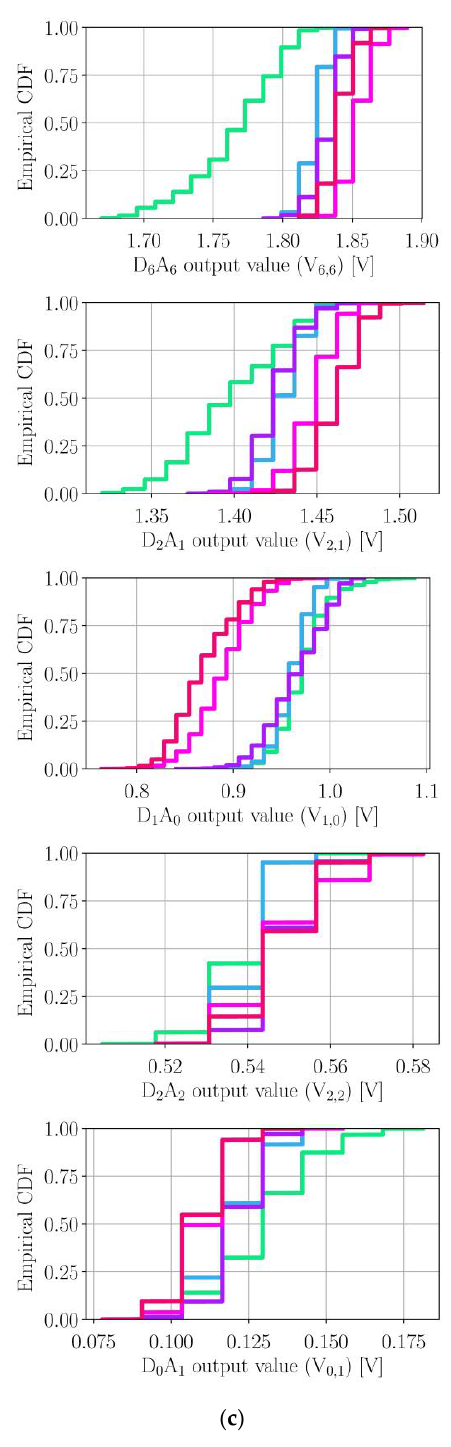
Figure 4. Results of the stability experiment, only including folded states. ( a ) Visualization of the textile output in an example folded state; ( b ) textile sensor values in a folded state over the course of 10,000 iterations. Raw data is shown in black for five matrix points, with corresponding CDFs in ( c ), the other curves are 1000-sample running averages corresponding to the remaining matrix points ( c ). Time-windowed empirical CDFs of the raw data curves are shown in ( b ). Each CDF curve corresponds to an interval in ( b ), as indicated by the